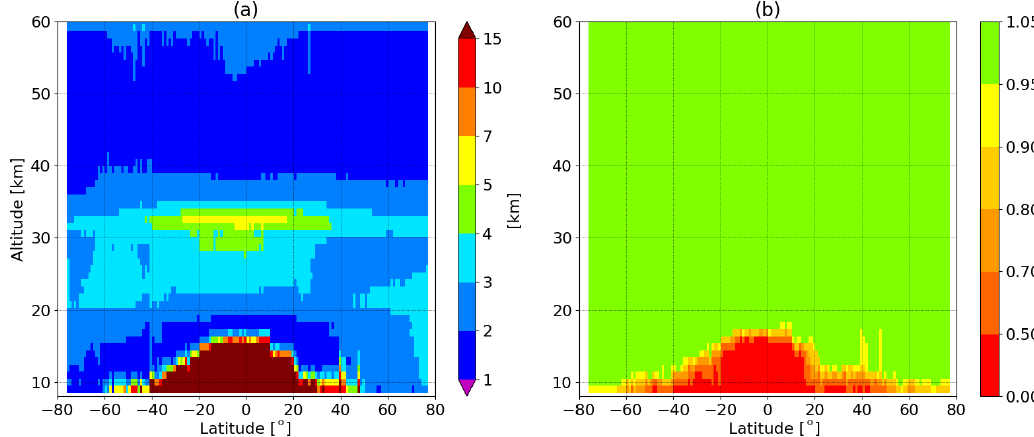
√ RMS) in the Chappuis band. The